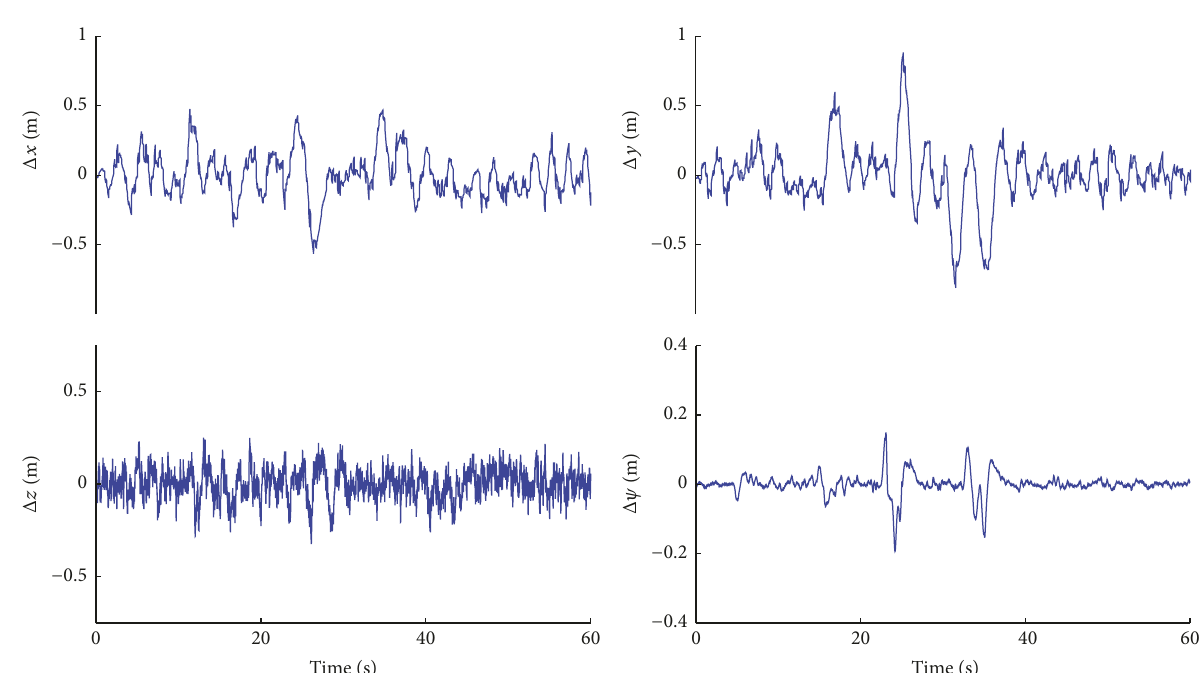
Figure 8: Time evolution of the tracking errors. The oscillatory behavior around zero is due to the presence of external disturbances and noisy